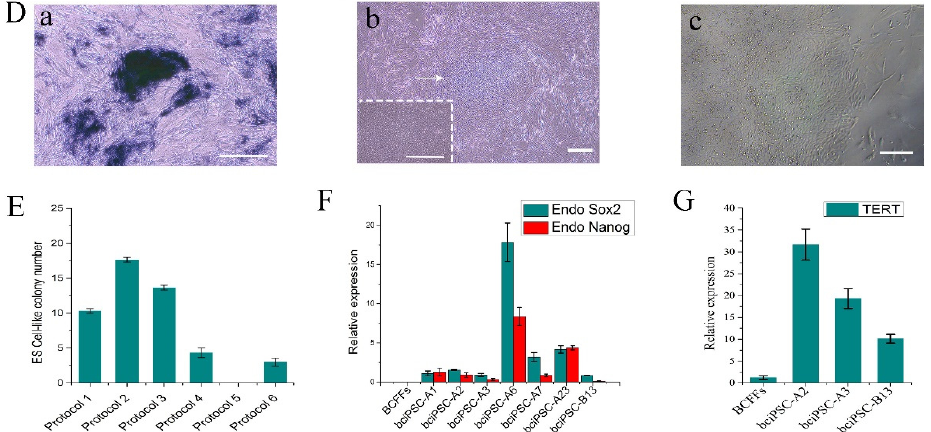
Figure 1. Acquisition of bciPSCs. ( A ) a , PMXS-EGFP plasmid map; b , modified PMXS-Sox2 plasmid map; ( B ) a , vim protein immunofluorescence identification of BCFFs (20×, 50 μ m), b , vim protein immunofluorescence identification of MEFs (20×, 50 μ m); ( C ) schematic diagram of the process; ( D ) a , AP positive clone (20×, 50 μ m), b , bciPSCs clone (4×, 250 μ m; 20×, 50 μ m), c , P1 of bciPSCs (10×, 100 μ m); ( E ) histogram of the number of AP positive clones obtained by six cell induction culture protocols; ( F ) qRT-PCR results of Sox2 and Nanog in BCFFs and seven bciPSC lines; ( G ) telomerase activity detection of bciPSCs and BCFFs.